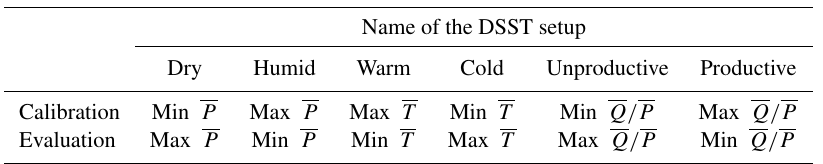
Table 1. Summary of the different setups of the DSST. Q , P and T , respectively, stand for average observed streamflow, precipitation and temperature computed on the sub-periods.